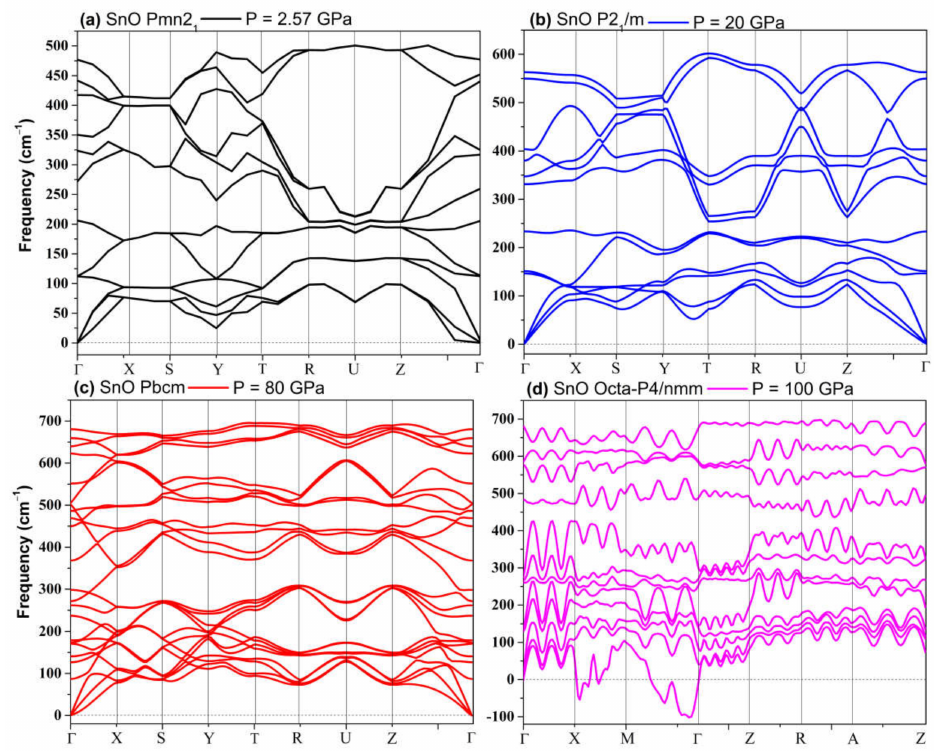
Figure 7. Phonon dispersion of structures of SnO: ( a ) Pmn2 1 ; ( b ) P2 1 /m ; ( c ) Pbcm ; ( d ) octahe- dral P4/nmm